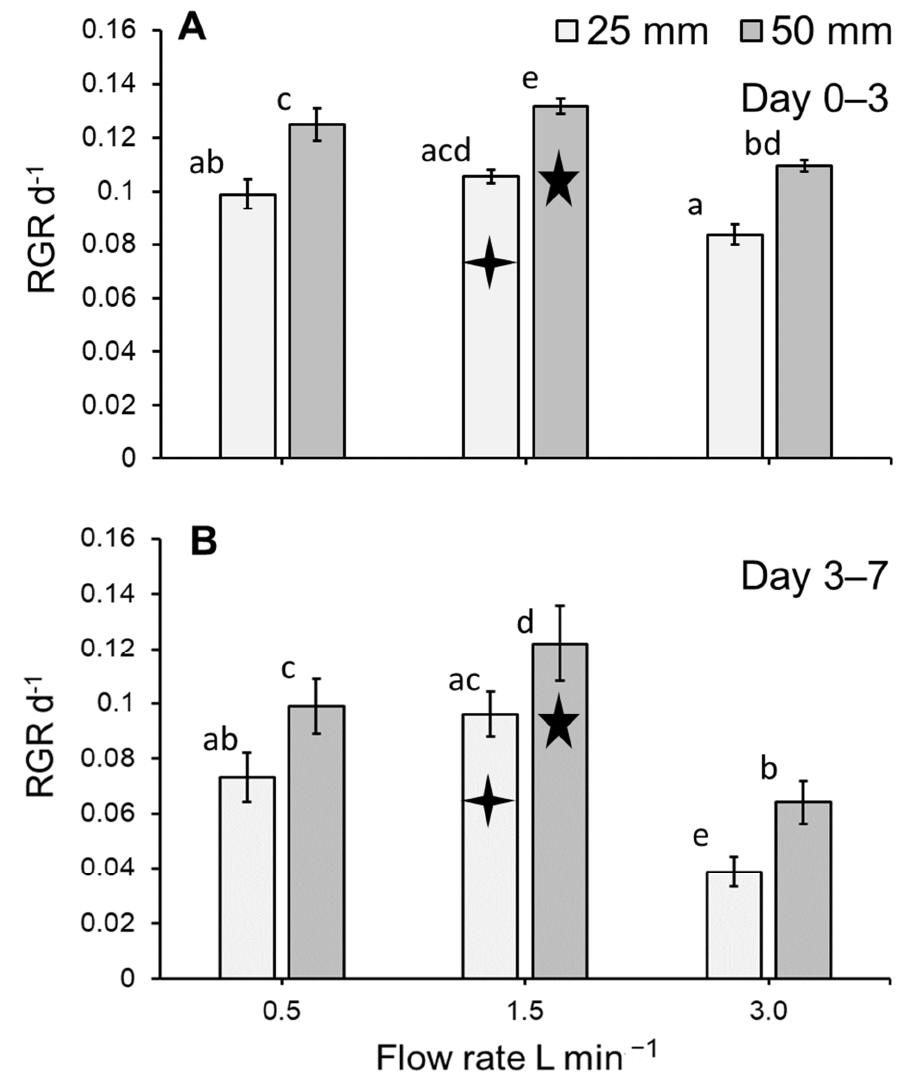
Figure 4. Mean ( ± SE) RGR (d − 1 ) for Lemna minor grown within an indoor, vertically stacked system. RGR between inoculation and the intermediate harvest (day 0–3; ( A ) and the final harvest (day 3–7; ( B ) are shown. As no effect of tray position was detected, trays have been pooled in this simplified model depiction. Letters show statistical similarity within each harvest period separately (i.e., day 0–3 or 3–7), while symbols indicate similarity amongst the harvest periods within treatments ( p > 0.05). Similarity amongst harvest periods is considered for within each treatment only (see Table 1).